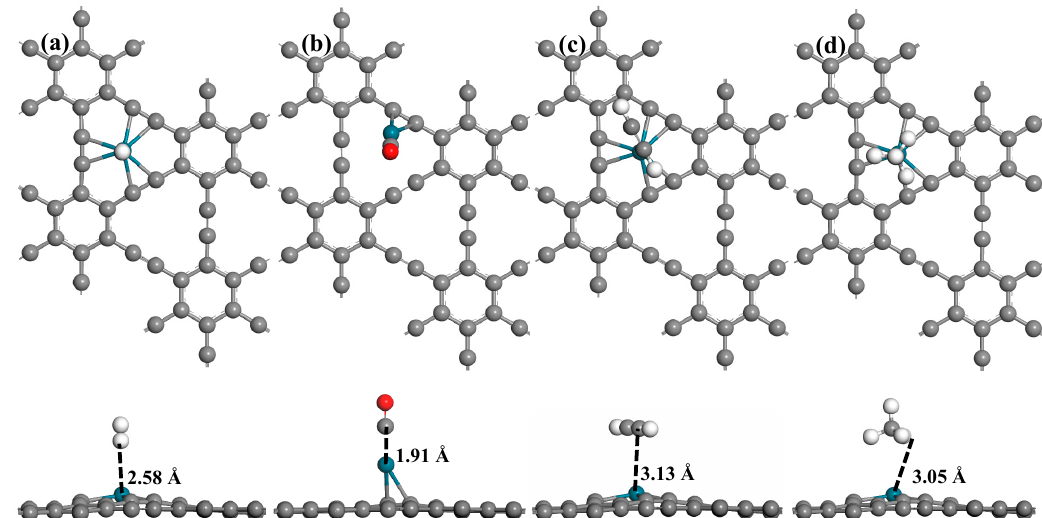
Figure 3. ( a ) Band structure and ( b ) TDOS of pristine graphyne; ( c ) Band structure and ( d ) TDOS of Pd-graphyne and PDOS of adsorbed Pd atom.